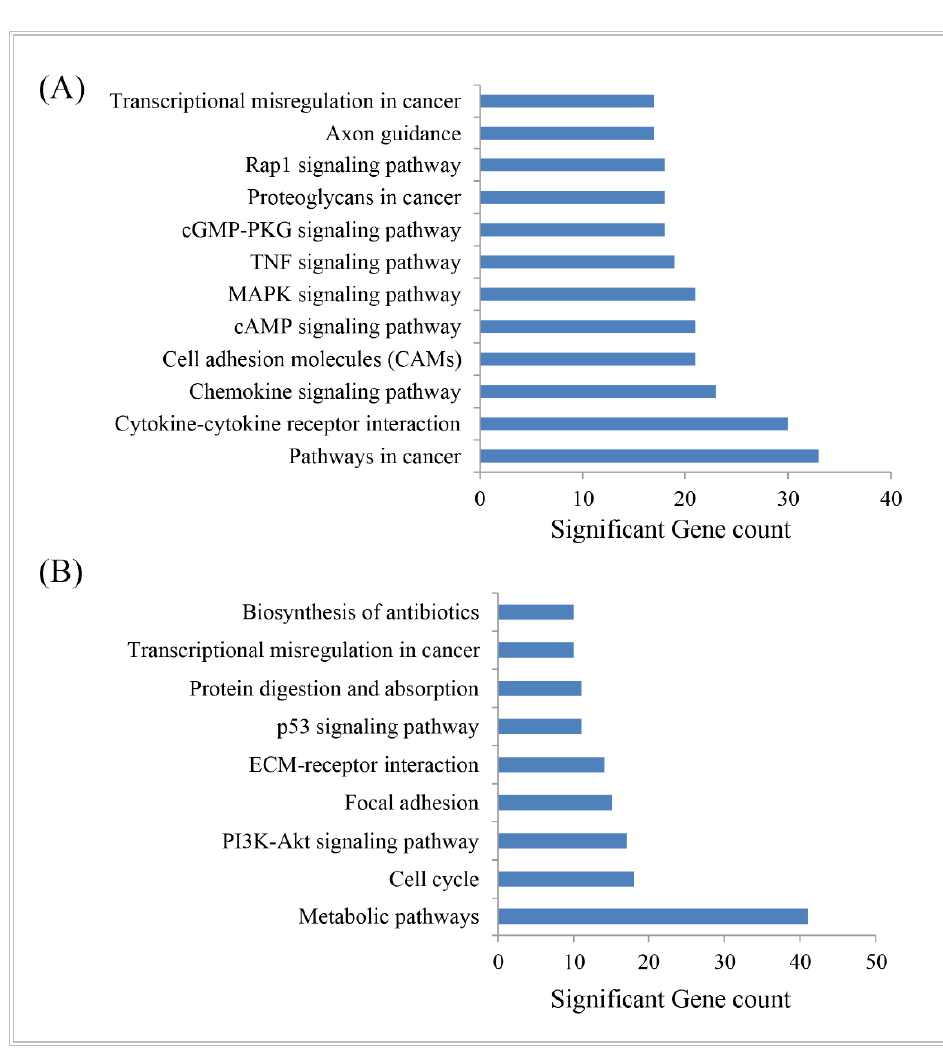
Figure 5. The KEGG pathways ( A ) for upregulated DEGs and ( B ) downregulated DEGs.